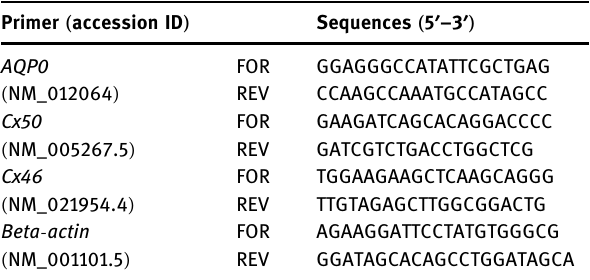
Table 2: Primers used for real - time PCR